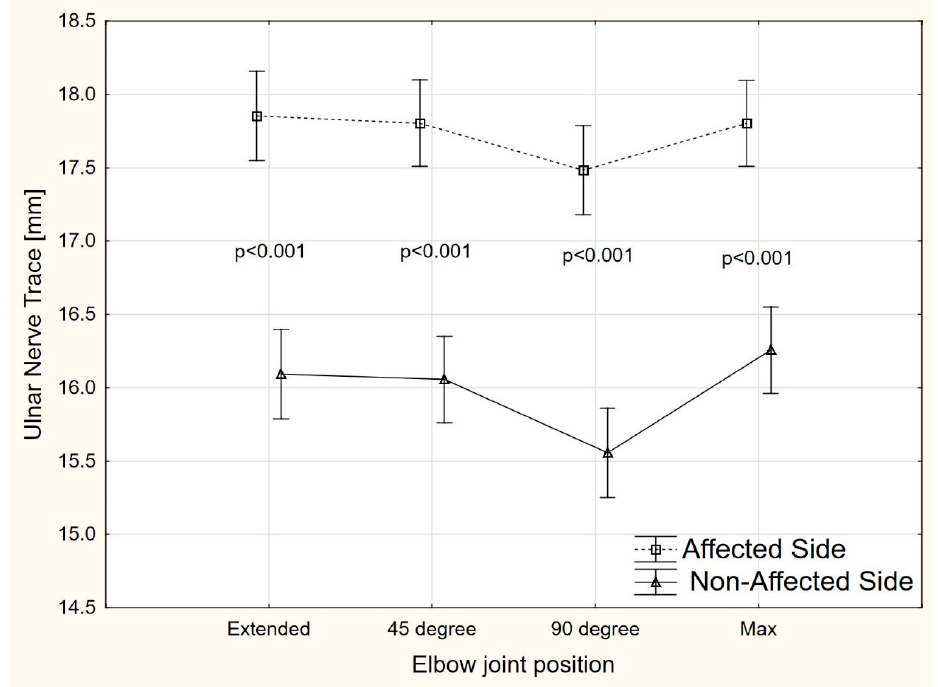
Figure 5. The TRACE changes in different positions of the elbow joint.